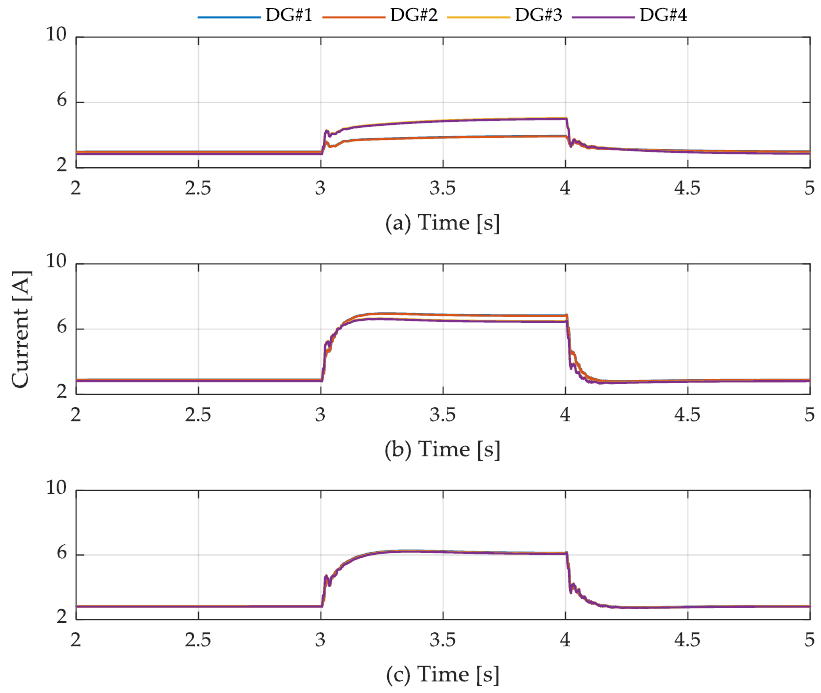
Figure 8. Output reactive power of each DG: ( a ) without LVRT; ( b ) centralized method; ( c ) proposed method.